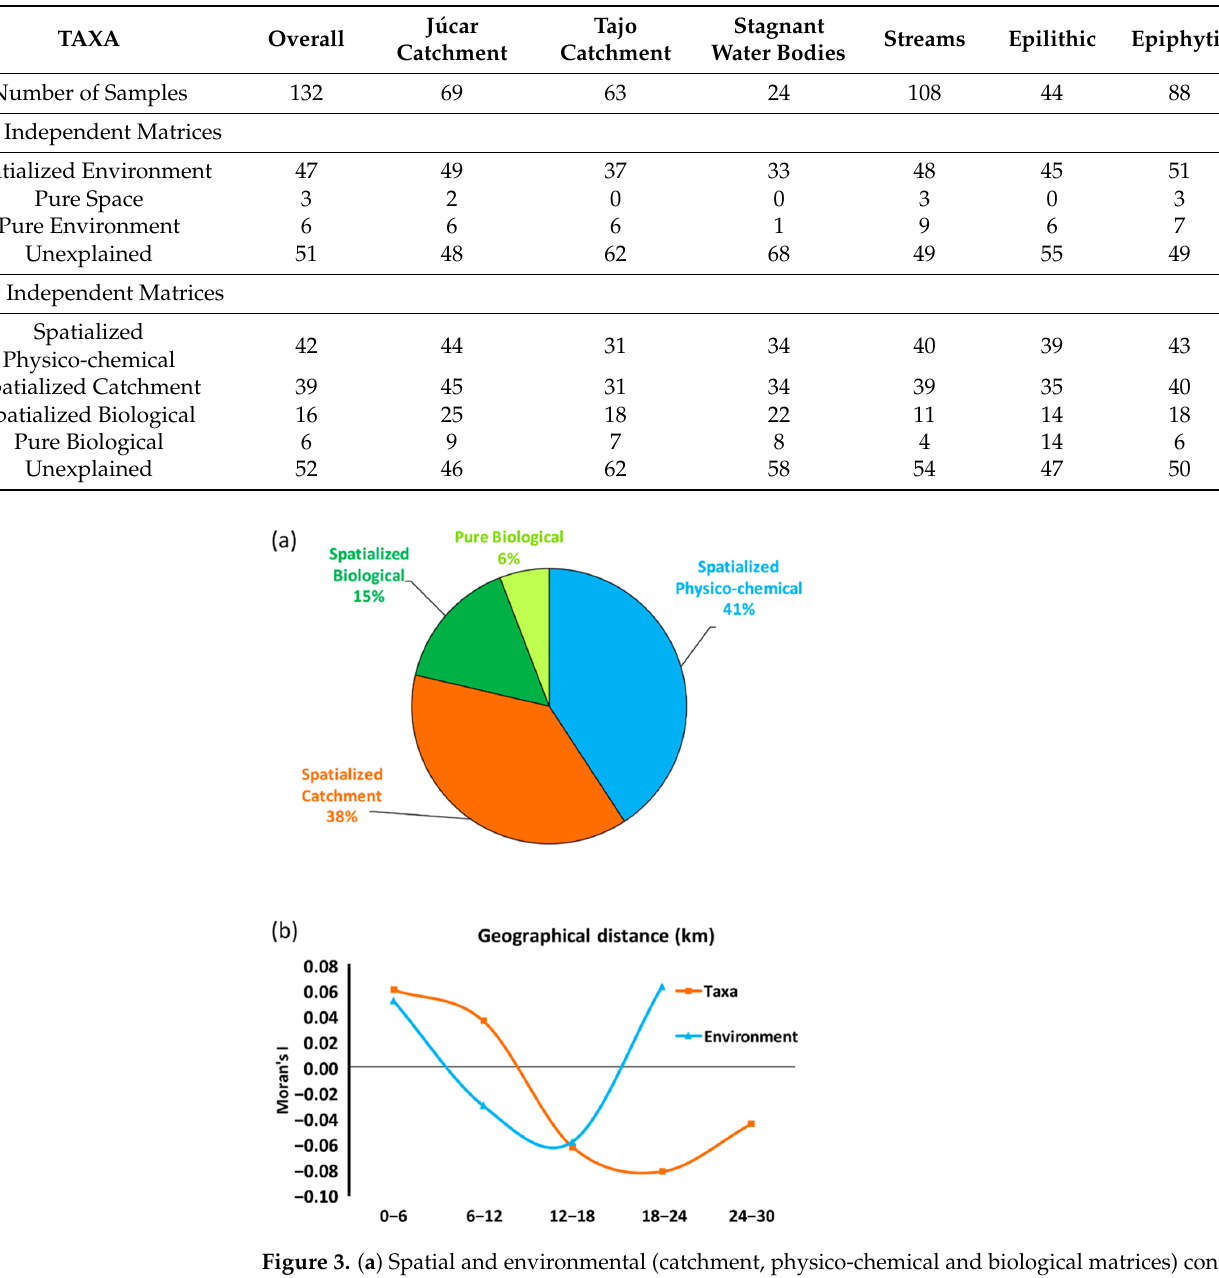
Table 5. Spatial and environmental relative contribution (%) to total explained variation of relative abundance of benthic diatom taxa. RDA results correspond to overall samples and different sets of samples and performed on spatial and environmental factors or on spatial and three environmental matrices (physico-chemical, catchment and biological). Pure means without interaction with other matrices. Only statistically significant results ( p < 0.05) are shown.